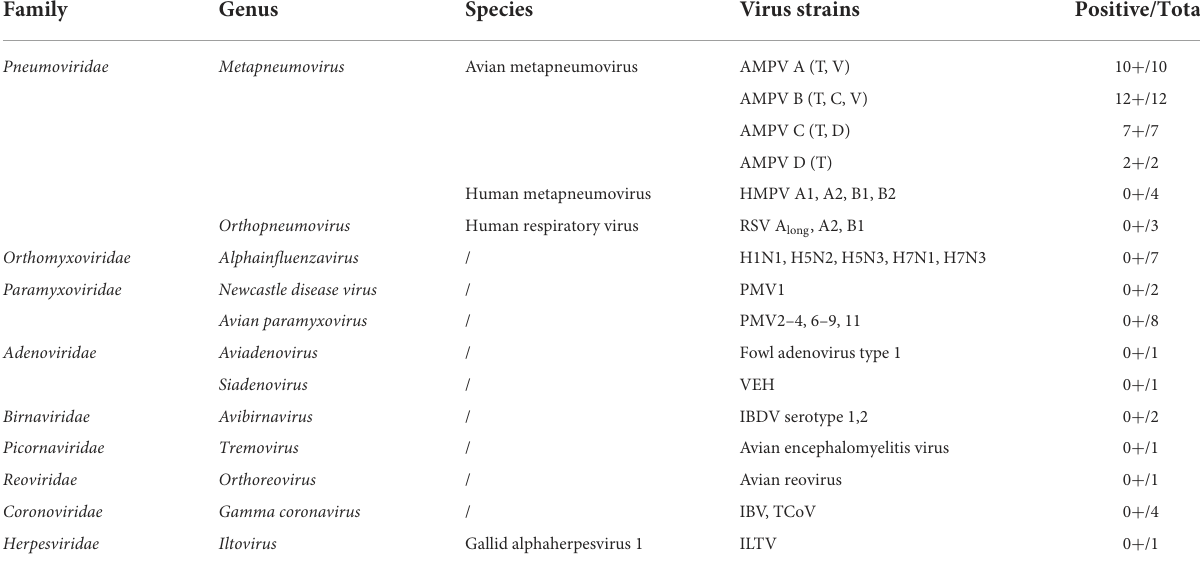
TABLE 2 Results of the five-plex RT-ddPCR AMPV with viruses used for specificity assessments. Family Genus